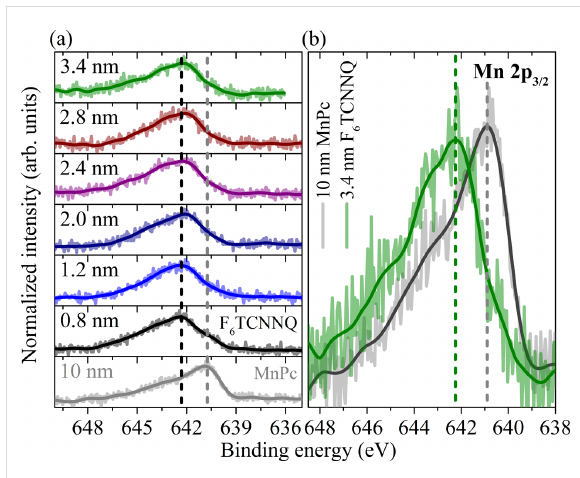
Figure 10: Core-level photoelectron spectroscopy data in the energy region of the Mn 2p 3 / 2 core level for the MnPc/F 6 TCNNQ interface. Panel (a) shows the data as a function of F 6 TCNNQ thickness on top of MnPc (as indicated), while panel (b) compares the Mn 2p 3 / 2 features for pure MnPc and with a 3.4 nm top layer of F 6 TCNNQ. There is a clear energy shift of 1.5 eV to higher binding energy.